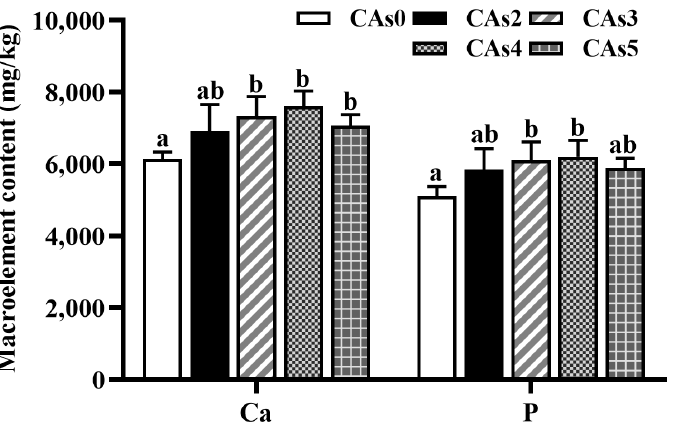
Figure 3. The contents of Ca and P in the whole fish of juvenile American eel in different CAs supplementation groups (wet sample basis). a,b Different superscripts on the bar mean the significant differences ( p < 0.05).